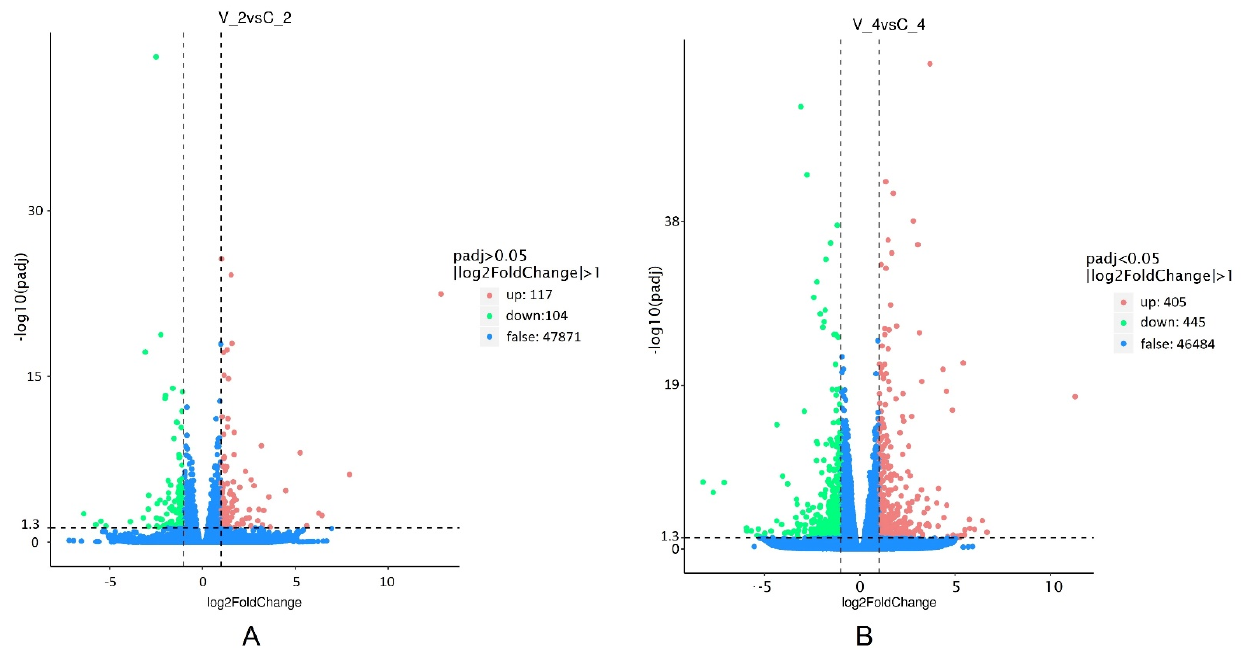
Figure 4. The number of differentially expressed genes (DEGs) in response to BRV infection at 2 ( A ) and 4 dpi ( B ) in R. nigrum cv. Aldoniai. The threshold is normally set as: [log2 (Fold Change)] > 1 and q-value < 0.005. The x -axis shows the fold change in the gene expression between different samples, and the y -axis shows the statistical significance of the differences. Statistically significant differences are represented by red or green dots.